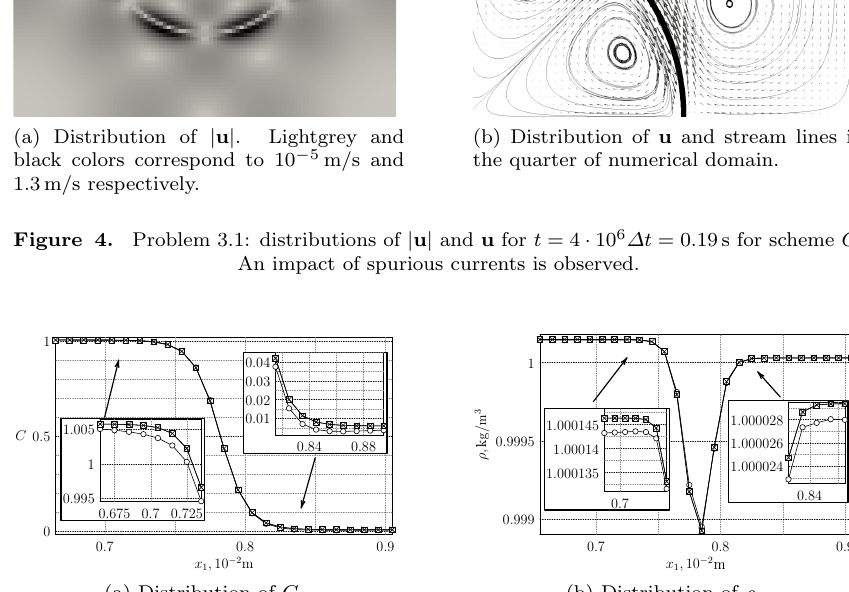
[0 . 5 X,X ] and x 2 = 0 . 5 X in the ∈ and correspond to × ◦